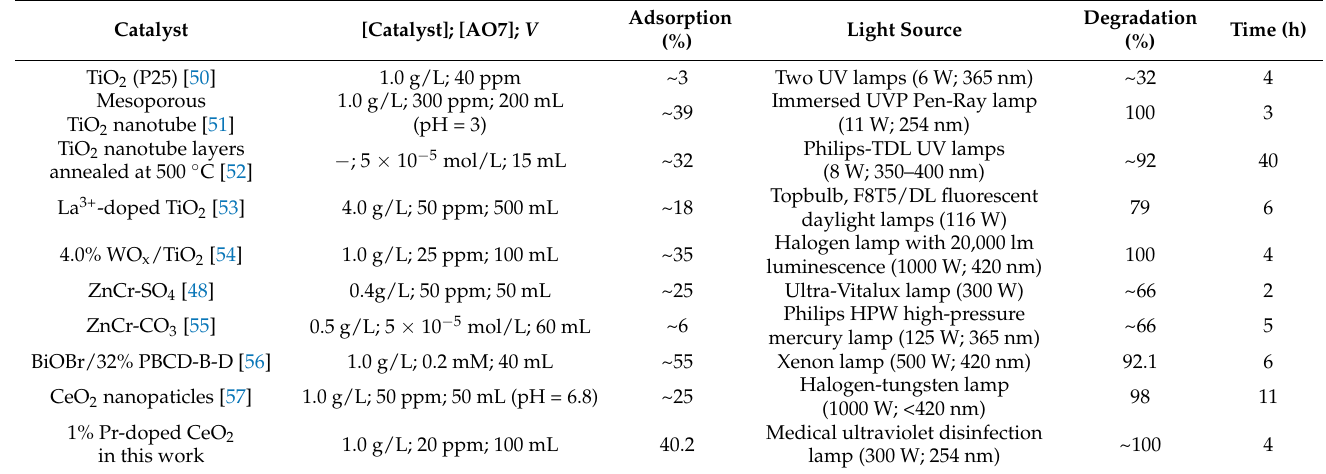
Table 3. Recent literatures on the development for the degradation of AO7